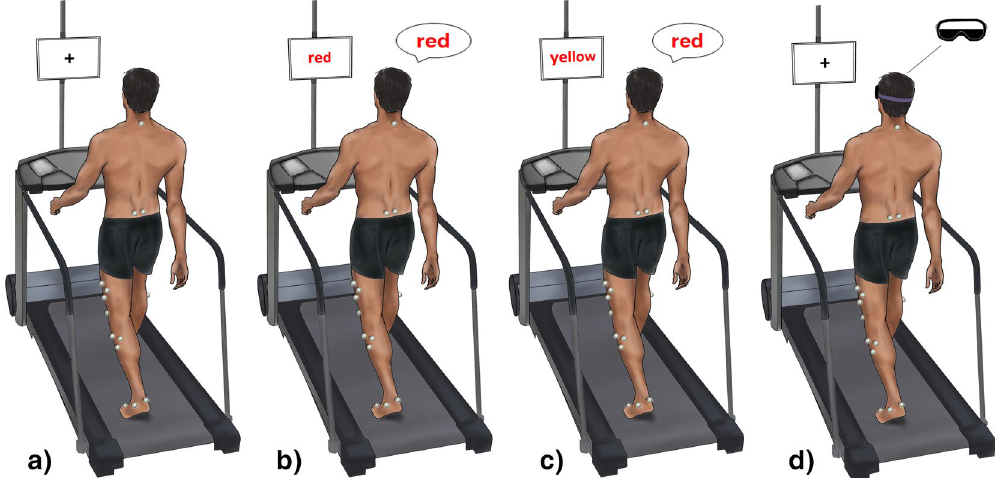
Figure 1. Experimental setup. Healthy adults aged 20–80 underwent 3D gait analysis while walking on an instrumented treadmill without handrail support. They undertook four locomotor tasks. Normal walking without a secondary task ( a ) was performed with the eyes fixed on a cross at eye height. Participants then walked while engaged in two Stroop colour-naming task (see methods) of differing difficulty. Image ( b ) shows the simpler task in which word and colour stimuli are congruent. In the more difficult, incongruent task ( c ) word and colour are discordant. Participants also carried out a visual restriction task in which they walked wearing eye goggles, the lower half of which were covered in black fabric to obscure the lower visual field. The upper edge of the fabric was affixed at the level of the subject’s interpupillary line. This figure was adapted from Fig. 1 in the publication Killeen et al . Increasing cognitive load attenuates right arm swing in healthy human walking. R. Soc. open sci. 2017 4 160993; DOI: 10.1098/rsos.160993. Published 25 January 2017 under the Creative Commons Attribution Licence